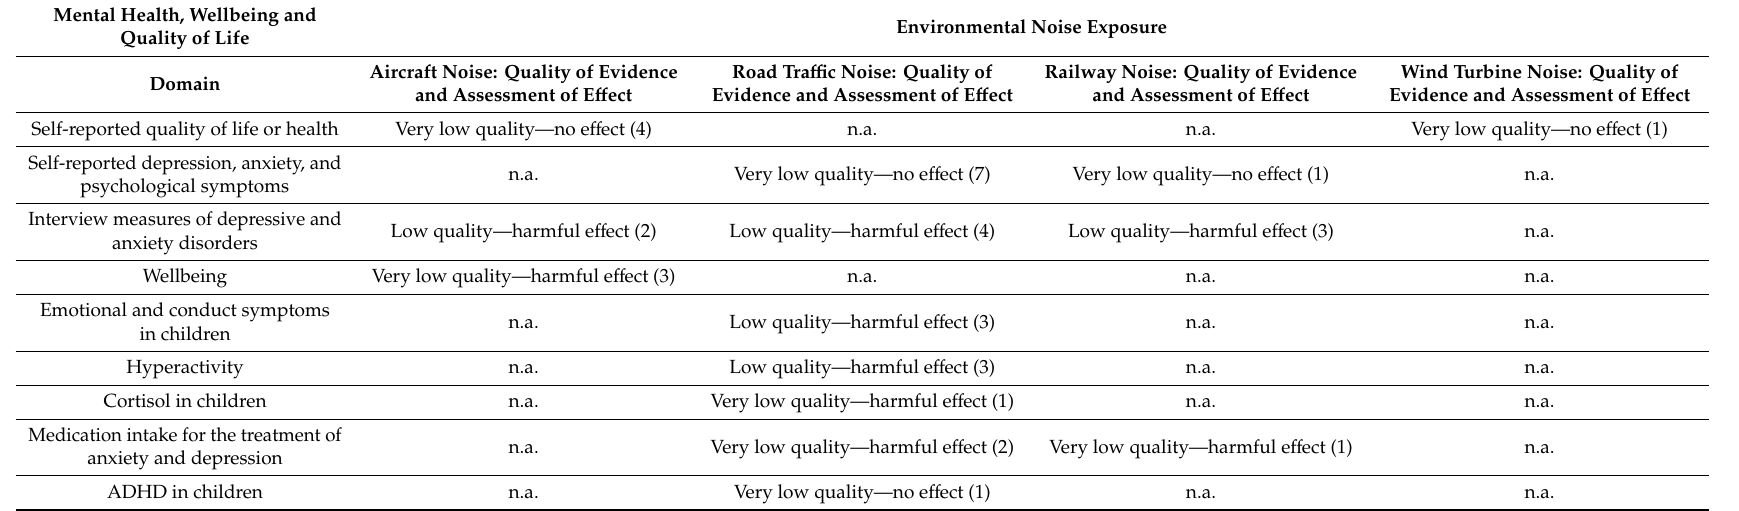
Table 7. Summary of the strength of the evidence for mental health, wellbeing, and quality of